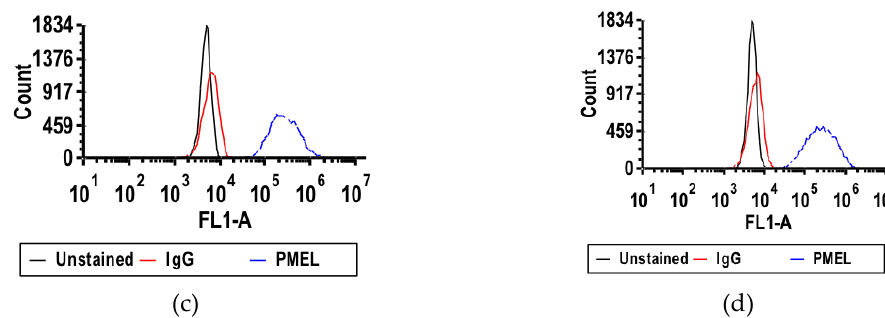
Figure 2. Purified population of PMEL expressing RPE cells and relevant gene expression at passage 0 on day 30: ( a ) measurable expression of RPE-specific genes ( RPE65 , BEST1 , RLBP1 , MITF2 , TYR , PAX6 , and P-MITF ); ( b ) high expression of TYRP1 and PMEL in immature RPE cells; ns equals not significant, N = 3;** p < 0.005; ( c ) PMEL expression (blue) in diseased RPE cells as compared to unstained (black) and IgG antibody control (red); ( d ) PMEL expression (blue) in corrected RPE cells as compared to unstained (black) and IgG antibody control (red).